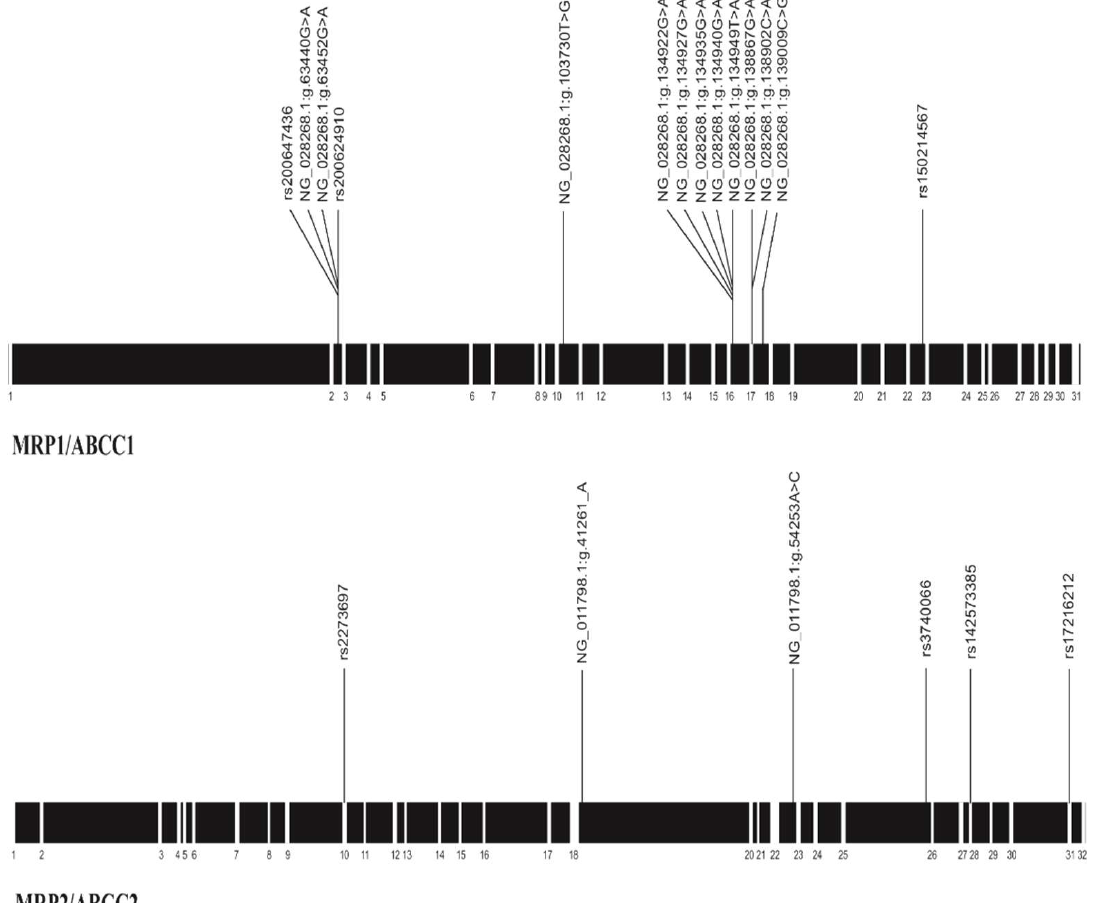
Figure 1. The distribution of polymorphisms identified in this study MRP1/ABCC1 and MPR2/ABCC2. The length of the rectangles is approximately proportional to the extent of exons. The new polymorphisms are highlighted. The black boxes are introns and the white ones, exons.